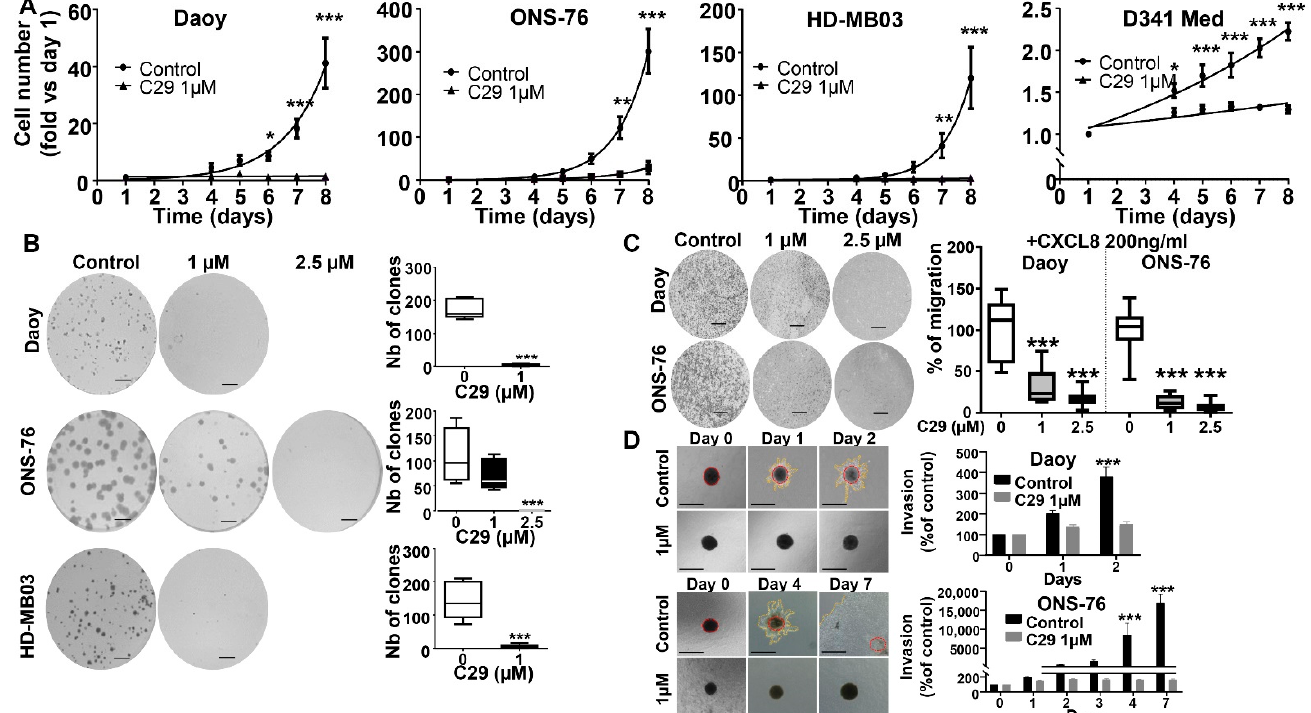
Figure 4. C29 reduces proliferation, migration, and invasion of naïve MB cells. ( A ) Proliferation of Daoy, ONS-76, HD-MB03, and D341Med wild-type cells after treatment with 1 µM C29 or the control (DMSO), n = 3. ( B ) Clonogenic assay on Daoy (n = 4), ONS-76 (n = 3) and HD -MB03 (n = 5) cells after treatment with control (DMSO) or C29 (1 µM or 2.5 µM). Scale = 500 µm. ( C ) Cell migration through the Boyden chamber of Daoy and ONS-76 cells specifically attracted by 200 ng/mL CXCL8. Results are expressed as percentage of control (DMSO) (n = 3). Scale = 1000 µm. ( D ) Spheroid invasion using 3D culture cell assays on Daoy (n = 4) and ONS-76 cells (n = 3) treated with control (DMSO) or C29 at a concentration of 1 µM on day 0, 1, and 2. Results are expressed as percentage of day 0, n = 4. Scale = 500 µm. Statistics were performed using Student t -test for 2 comparisons only or ANOVA test for multiple comparisons. * p < 0.05, ** p < 0.01, *** p < 0.001. HD-MB03 cells formed spheroids but were unable to invade the Matrigel matrix (Supplementary Figure S3B). D341Med cells did not form spheroids as they grow in